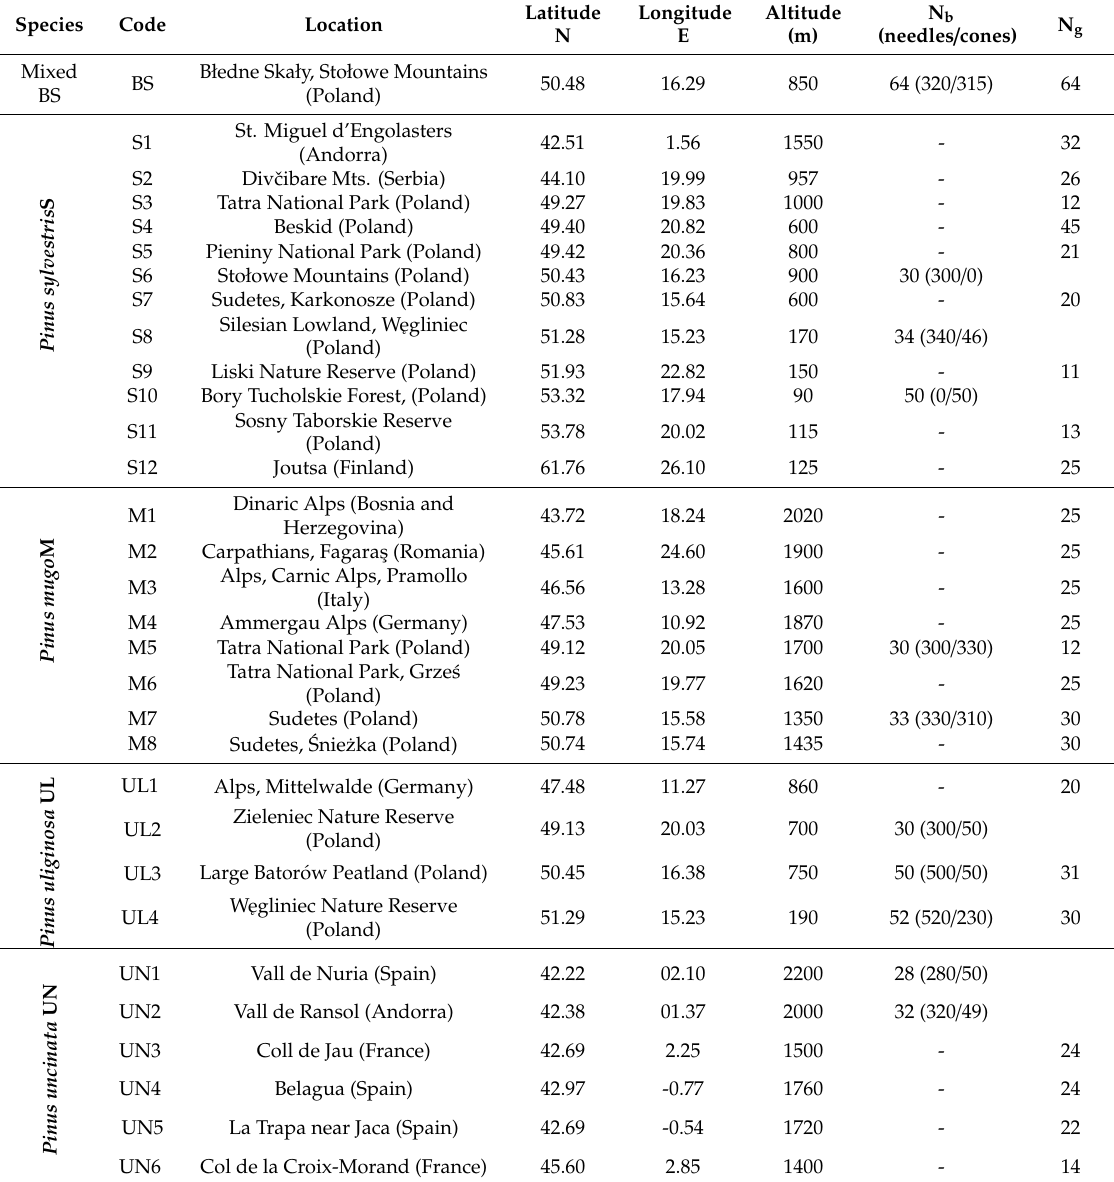
Table 1. Plant material used in the